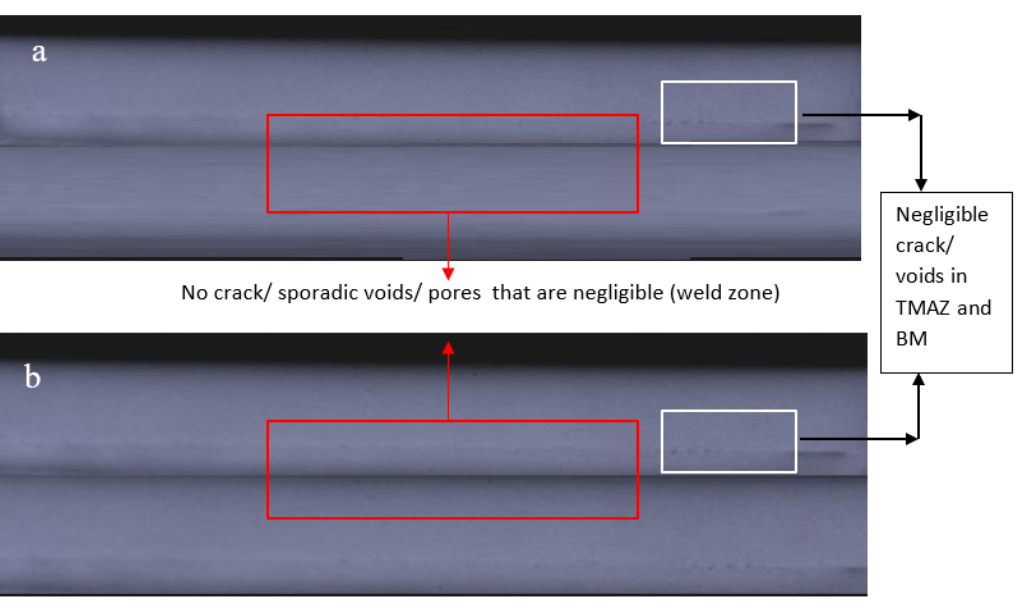
Figure 10. ( a ) Radiographic images of AA6061 welded composite plates reinforced with: ( a ) 5% SiC/8% B 4 C, ( b ) 3% SiC/10% B 4 C.